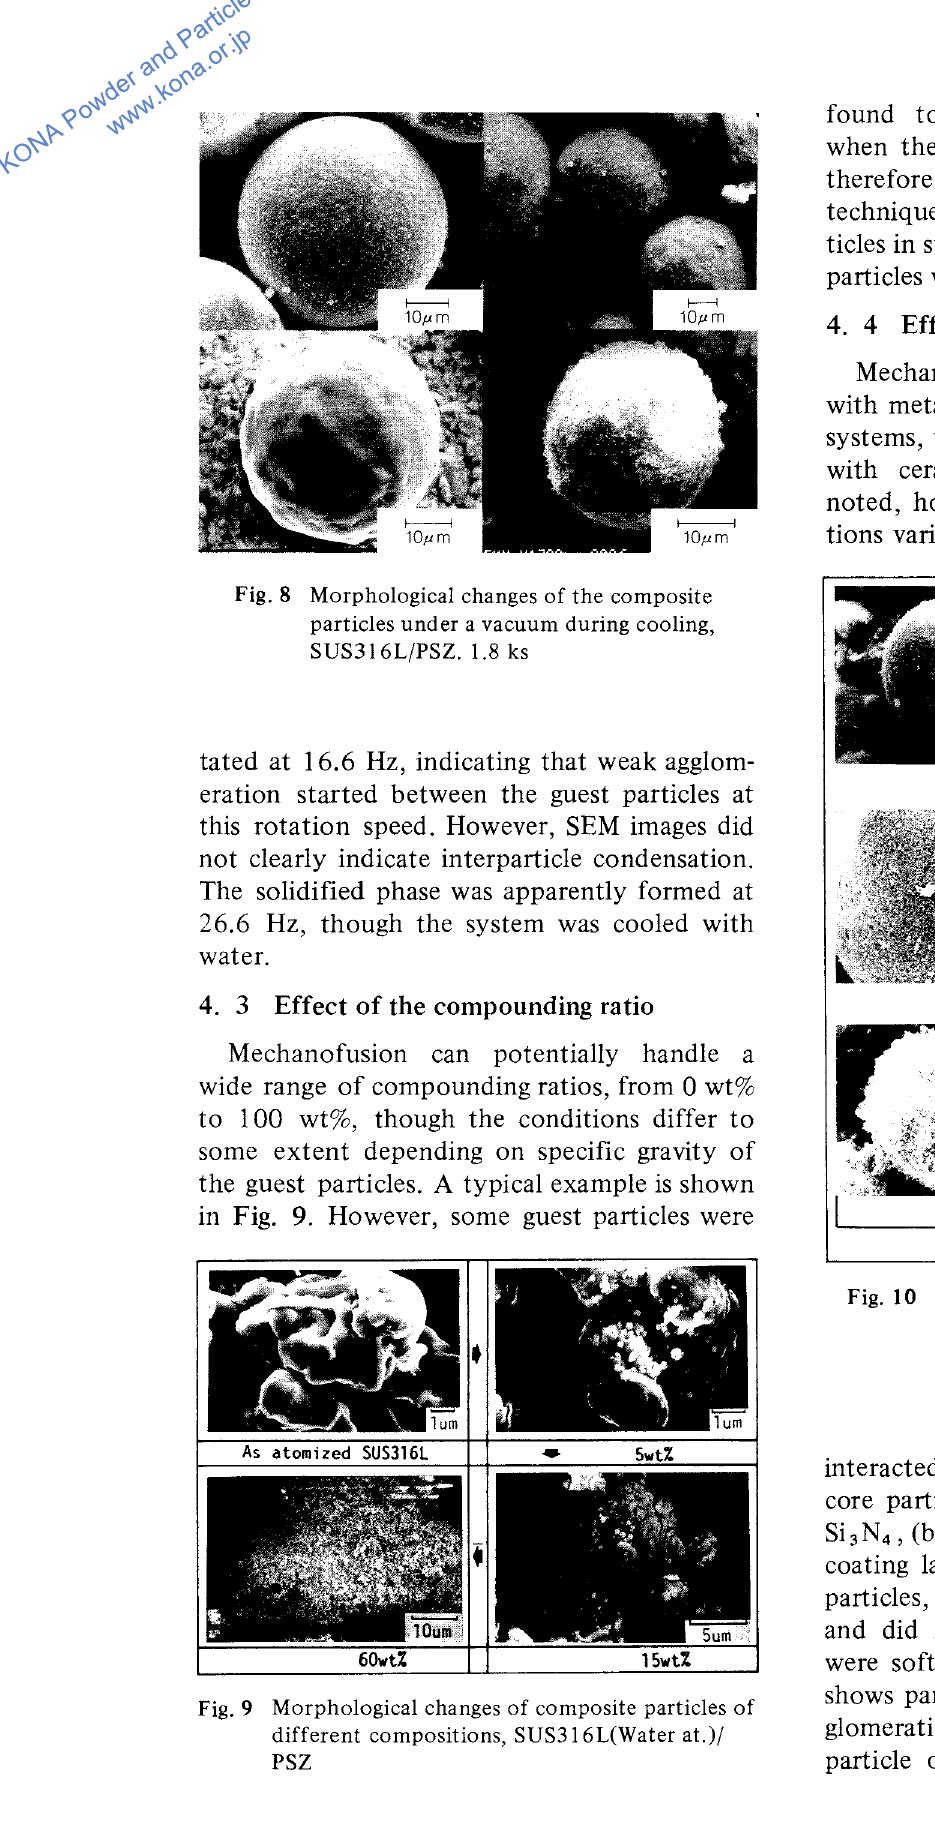
Fig. 9 Morphological changes of composite particles of different compositions, SUS316L(Water at.)/ PSZ